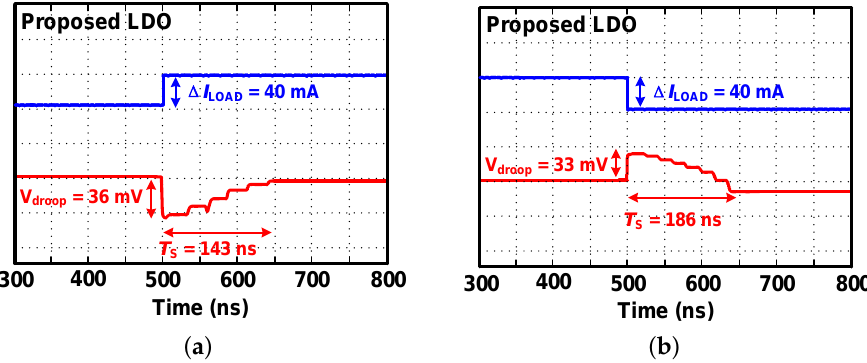
Figure 14. The transient responses of V OUT when I LOAD change of ( a ) step up and ( b ) step